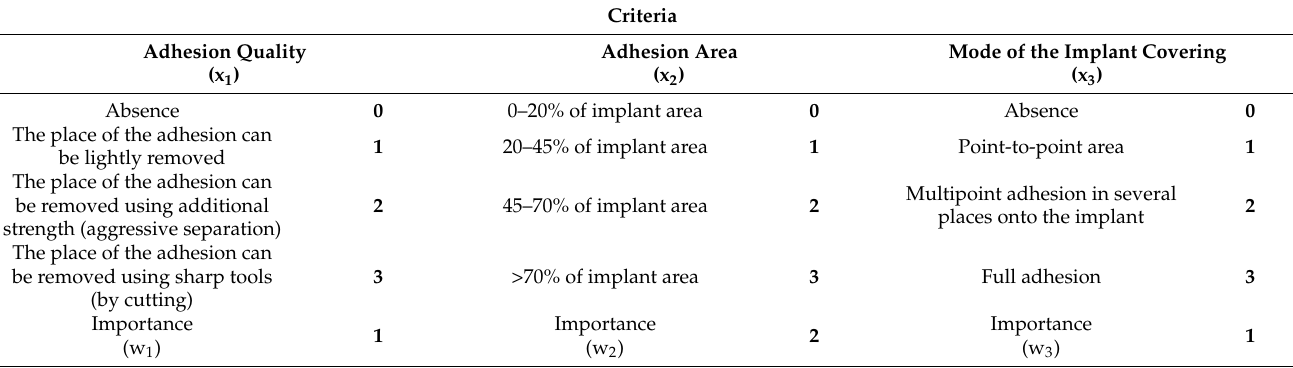
Table 3. Semi-quantitative analysis of the viscera adhesion to the implant. Criteria